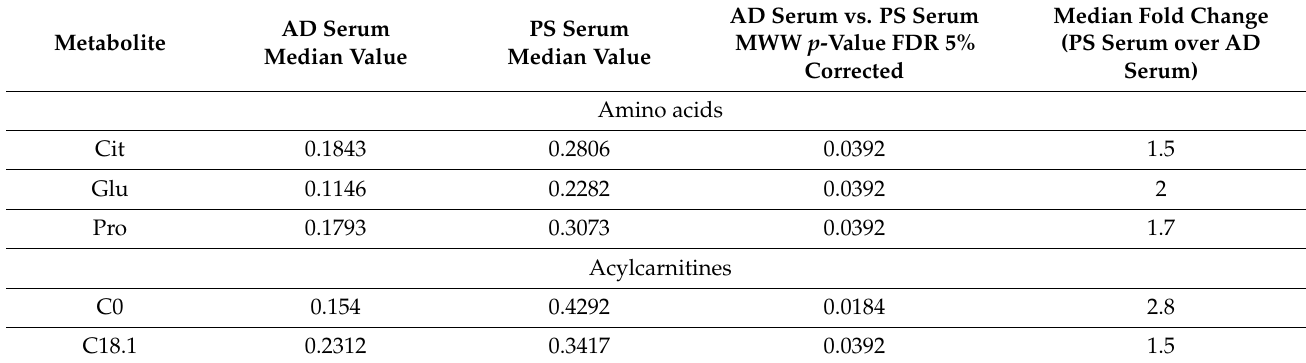
Table 2. Statistically significantly different metabolites between the blood serum samples from atopic dermatitis (AD) and psoriasis (PS)